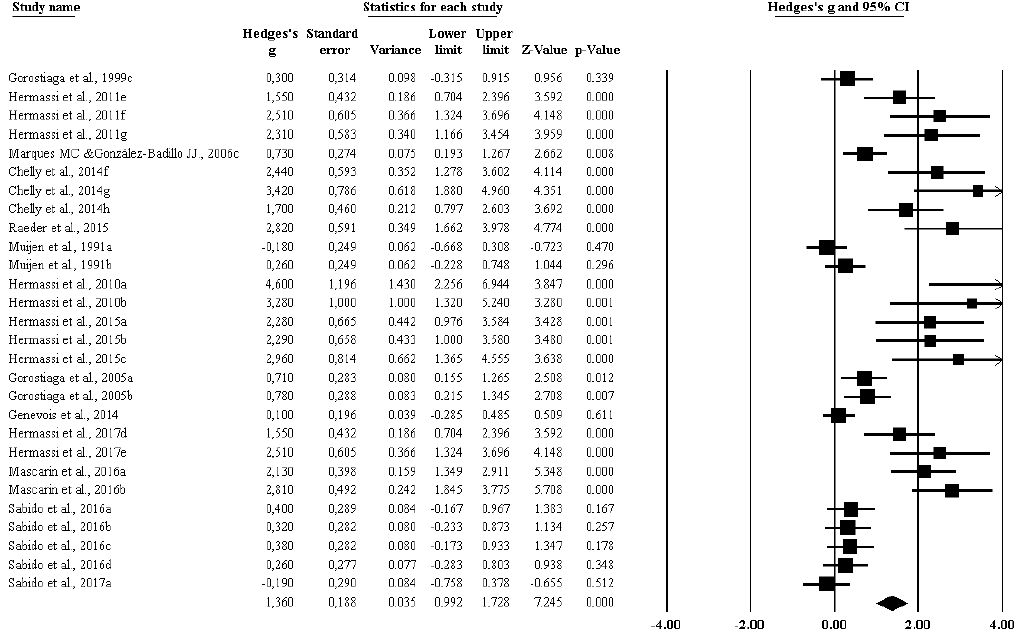
Figure 3. The impact of resistance training on throwing among handball players.